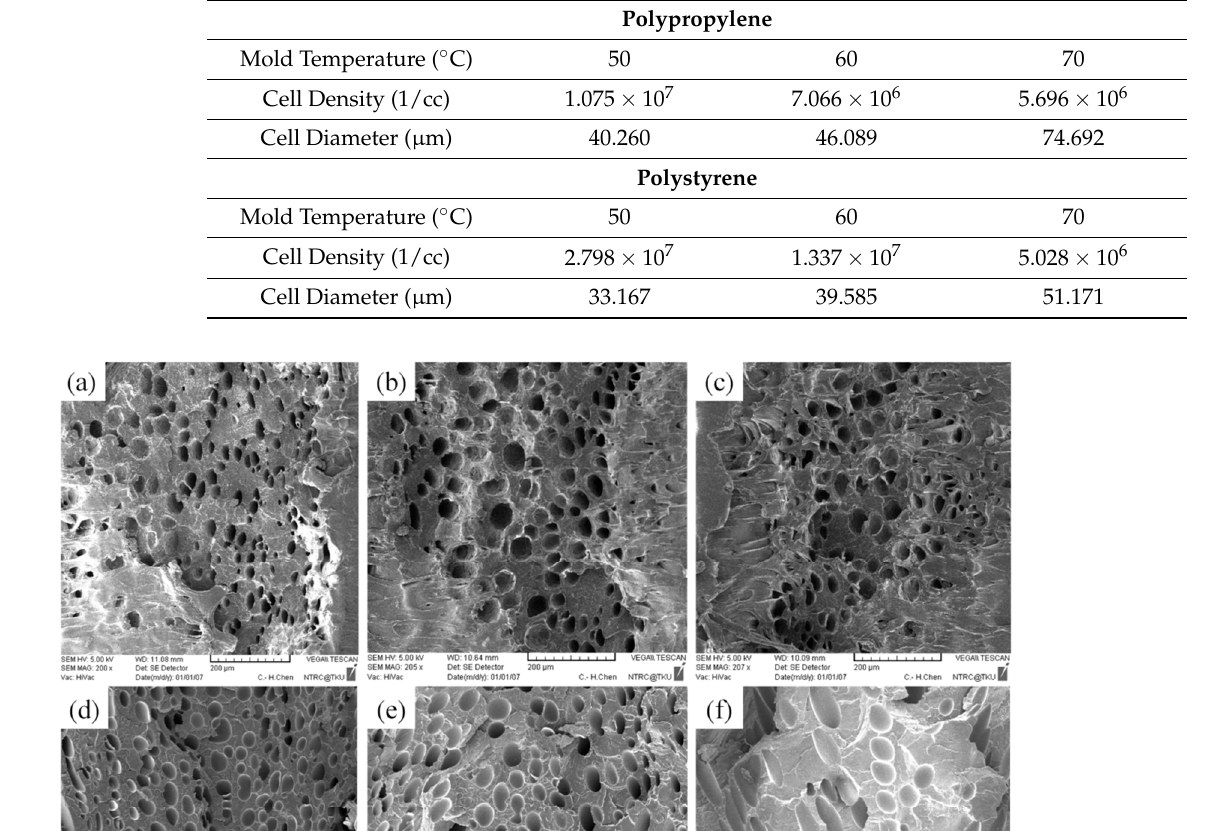
Table 9. Microscopic effects of mold temperature on the PP and PS cells as observed through the SEM.